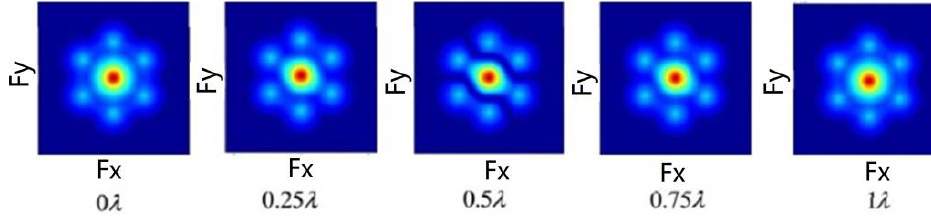
Figure 3. MTF for different piston errors.